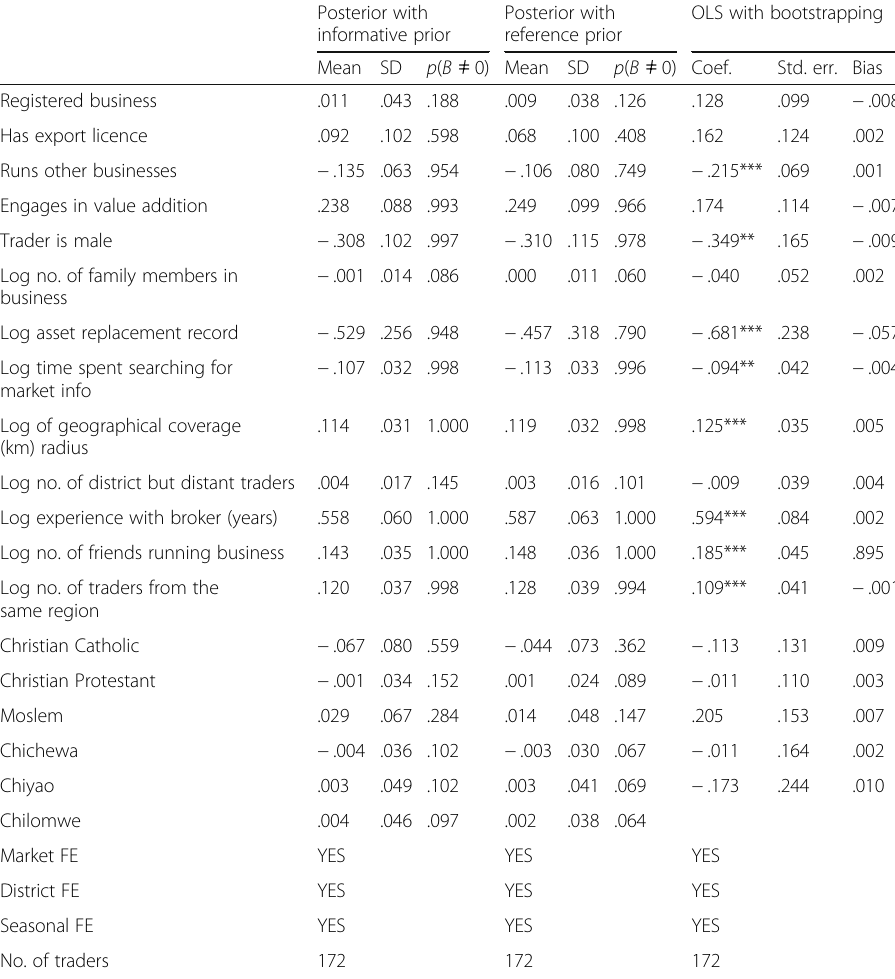
Table 7 Determinants of maize traders ’ business resilience in Malawi